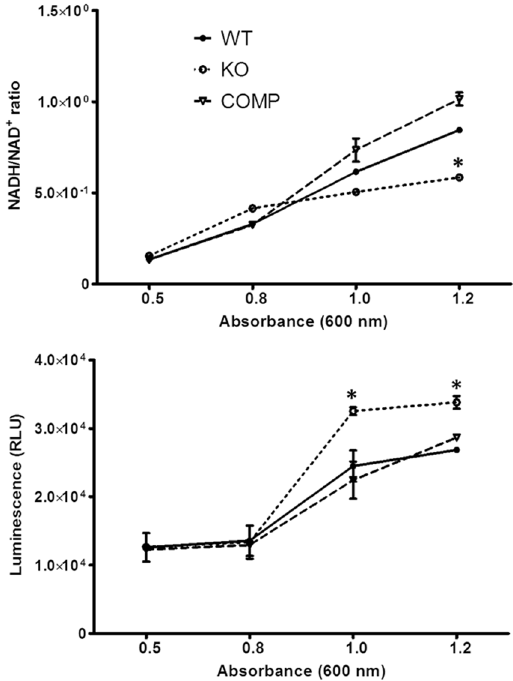
Figure 4. Comparison of intracellular NADH/NAD + ratio and ATP levels in WT, MDP1-KO and COMP. Mean levels of the intracellular NADH/NAD + ratio ( a ) and ATP ( b ) in WT, MDP1-KO and COMP determined by bioluminescence assay. Cultures grew to OD 600 values of 0.5, 0.8, 1.0, and 1.2. Each experiment was performed with three biological and three technical replicates. ANOVA was used to analyze the data and P - values < 0.05 (indicated by * ) were considered significant.